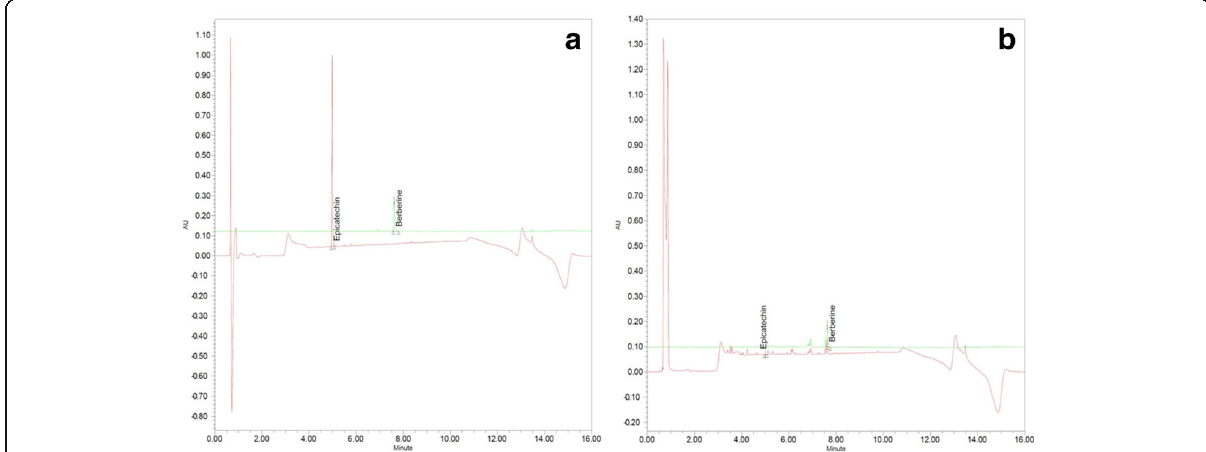
Fig. 1 Analysis of compounds in a mixture of Pelargonium sidoides and Coptis chinensis root (PS + CR) by ultra-performance liquid chromatography (UPLC). UPLC chromatograms of standard compounds; epicatechin: 230 nm, berberine: 345 nm. a standard compounds. b PS + CR